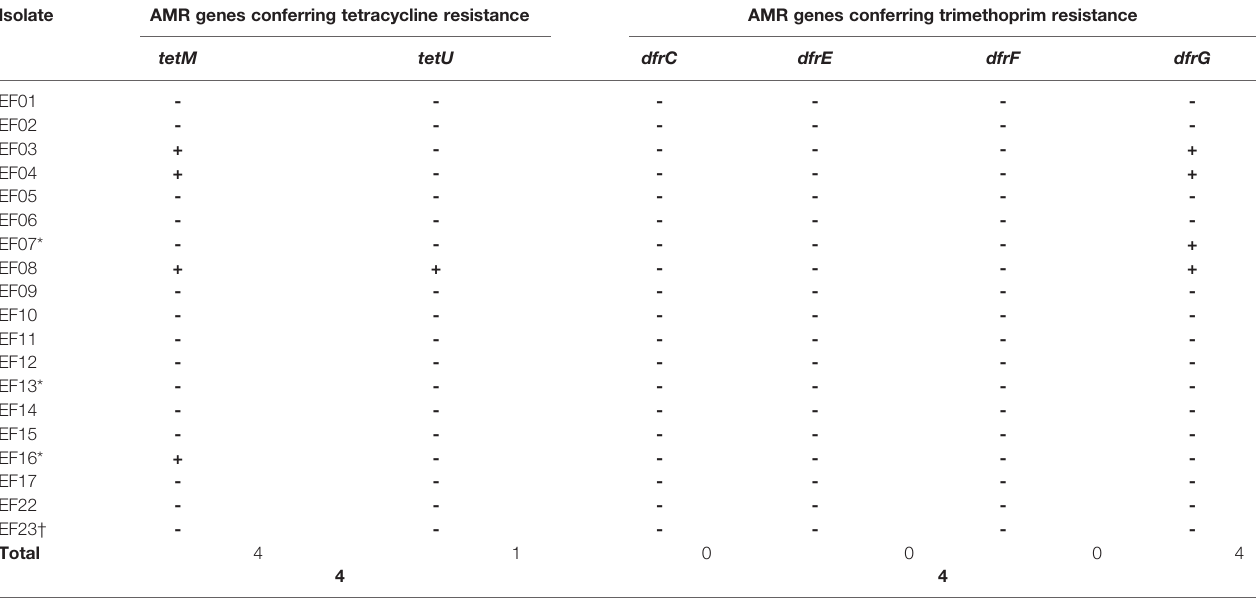
TABLE 5 | Genes detected by short-read next-generation sequencing that confer antimicrobial resistance (AMR) to tetracycline and trimethoprim. Isolate